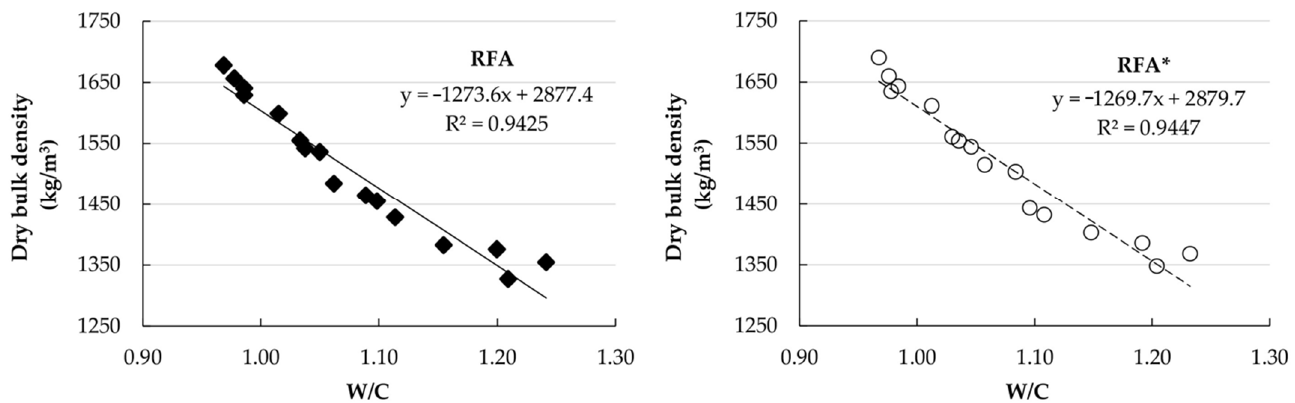
Figure 9. Correlation between dry bulk density and water/cement ratio.